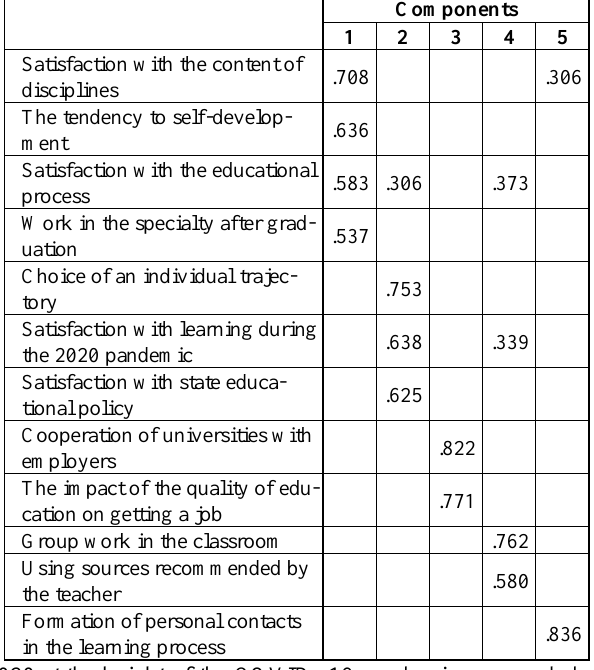
Table 1. Matrix of components after rotation To check the suitability of the data for factor analysis, the KMO sample adequacy test and the Bartlett sphericity test were used. The KMO criterion is 0.601. It shows that factor analysis is applicable to the selected data. The sphericity cri- terion has a statistical significance at the level of 0.001, which means that the correlation in the correlation matrix is statistically significantly different from zero, and this matrix is suitable for factor